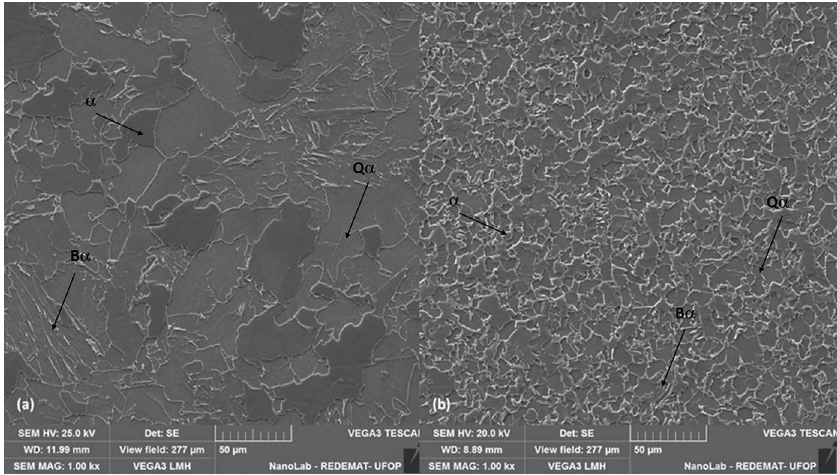
Figure 9. SEM micrographs of microstructures of (a) steel A and (b) steel B cooled with 10ºC/s - 1000X (α-polygonal ferrite, Qα- quasi-polygonal ferrite and Bα- bainitic ferrite).